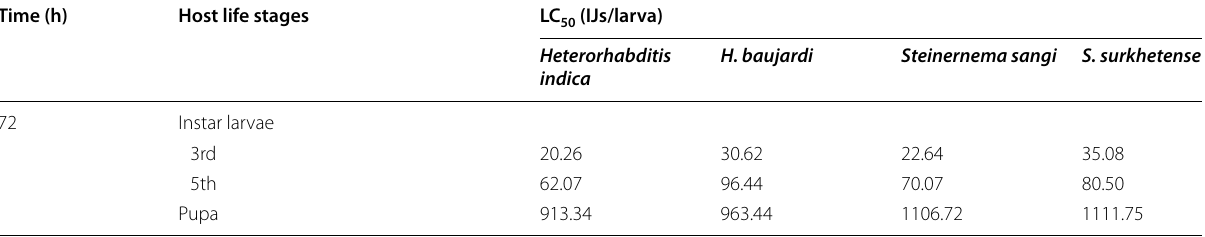
Table 1 Lethal concentration (LC ) of the four isolated EPN species on Spodoptera frugiperda 50 Time (h) Host life stages LC 50 (IJs/larva)